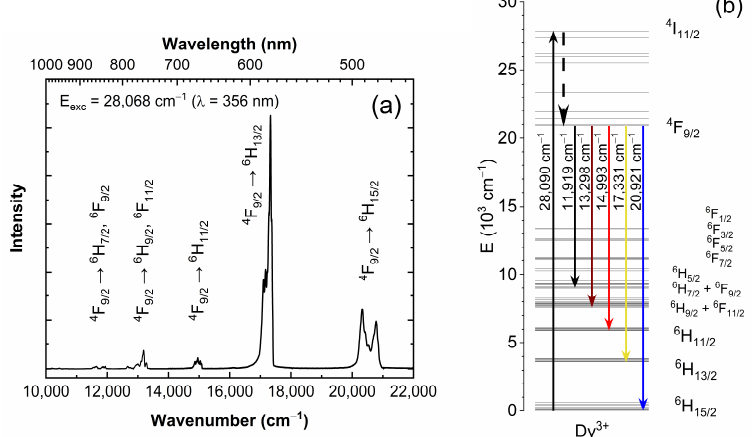
Figure 5. ( a ) Overview of the luminescence spectrum measured for Li 6 Y(BO 3 ) 3 :Dy(1 mol%) single crystal under excitation at 28,068 cm −1 at 4.2 K. ( b ) Energy level diagram of Dy 3+ ions in LYB crystal showing the excitation from the ground state and various emission lines.